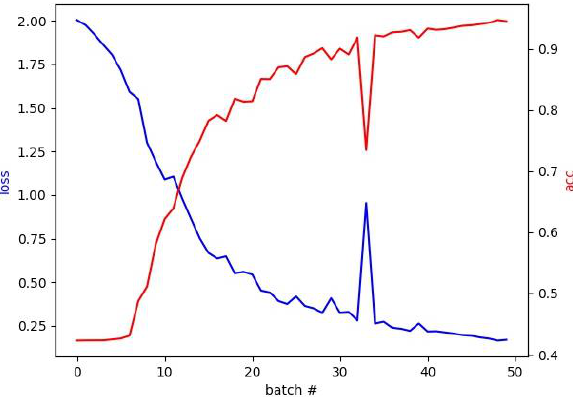
Figure 25. Validation loss and accuracy of the prediction with the highest test accuracy.